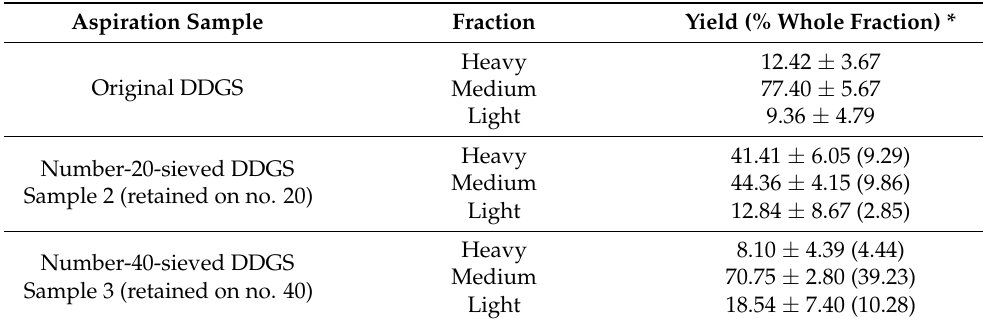
Table 2. Yield of different fractions of DDGS in aspiration